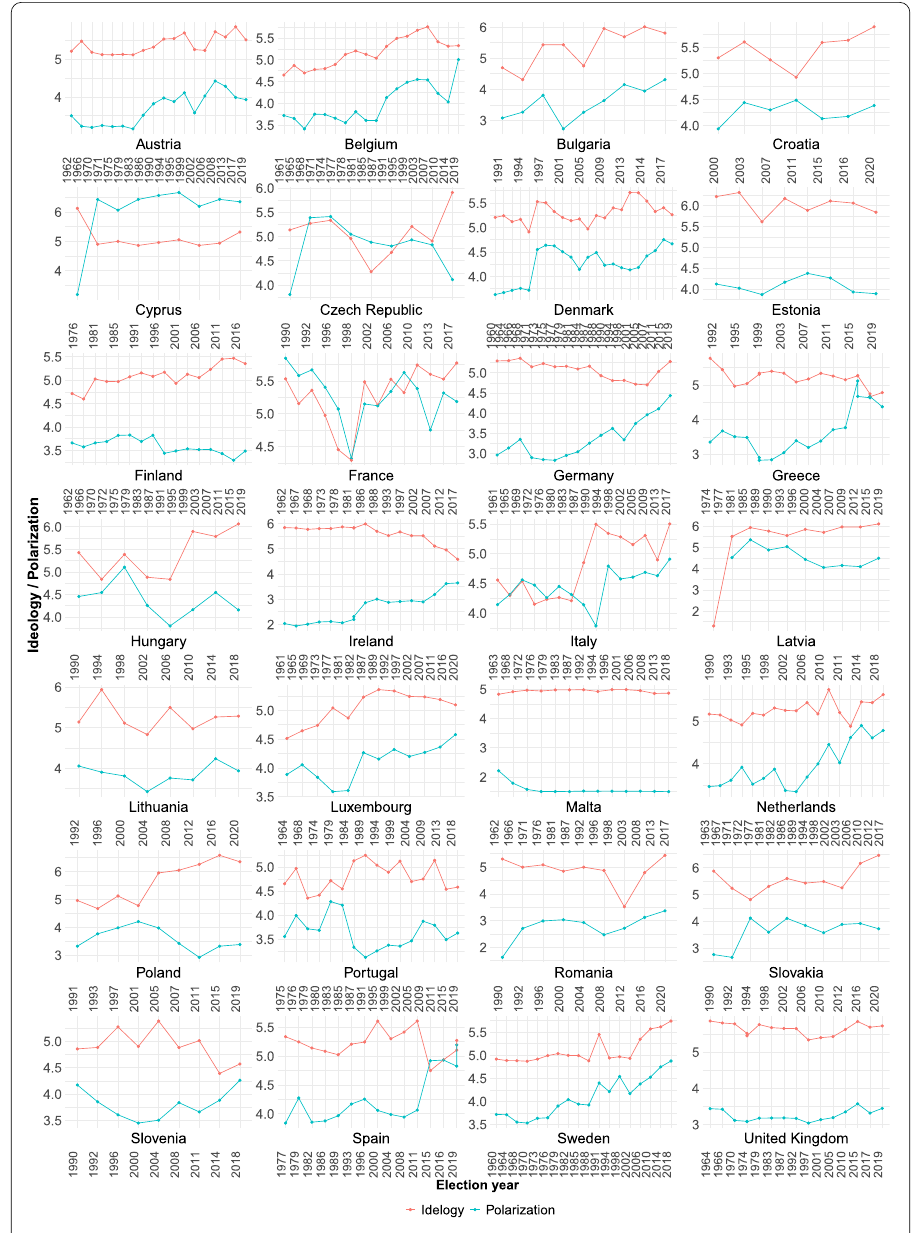
Figure 18 Ideology and Polarization evolution across the EU countries and the United Kingdom